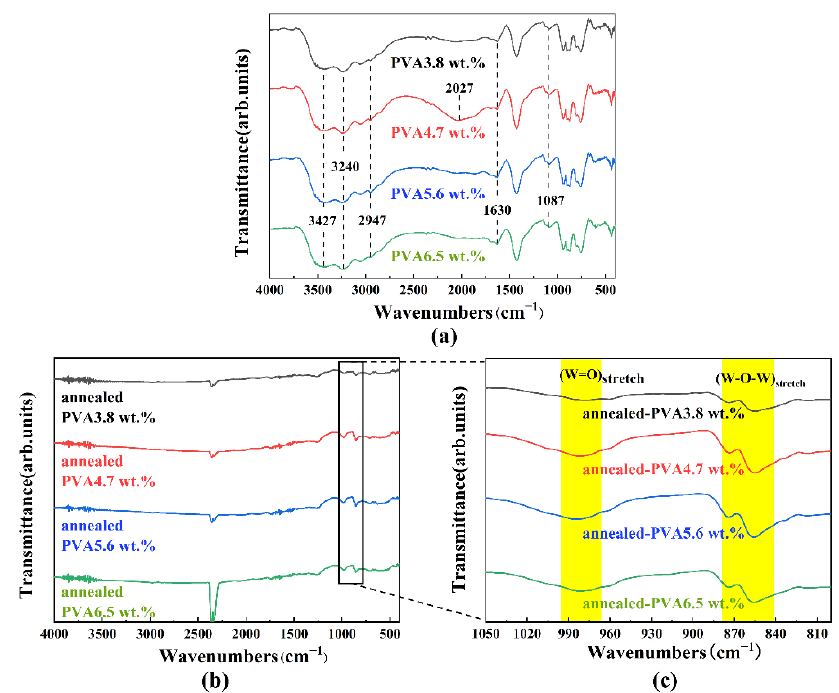
Figure 5. Fourier transform infrared (FT-IR) spectra of films: ( a ) screen printing PVA + FSO ink formulas without annealing process, ( b ) screen printing PVA + FSO ink formulas with annealing process, ( c ) enlargement in 1050–800 cm −1 wavenumber range.